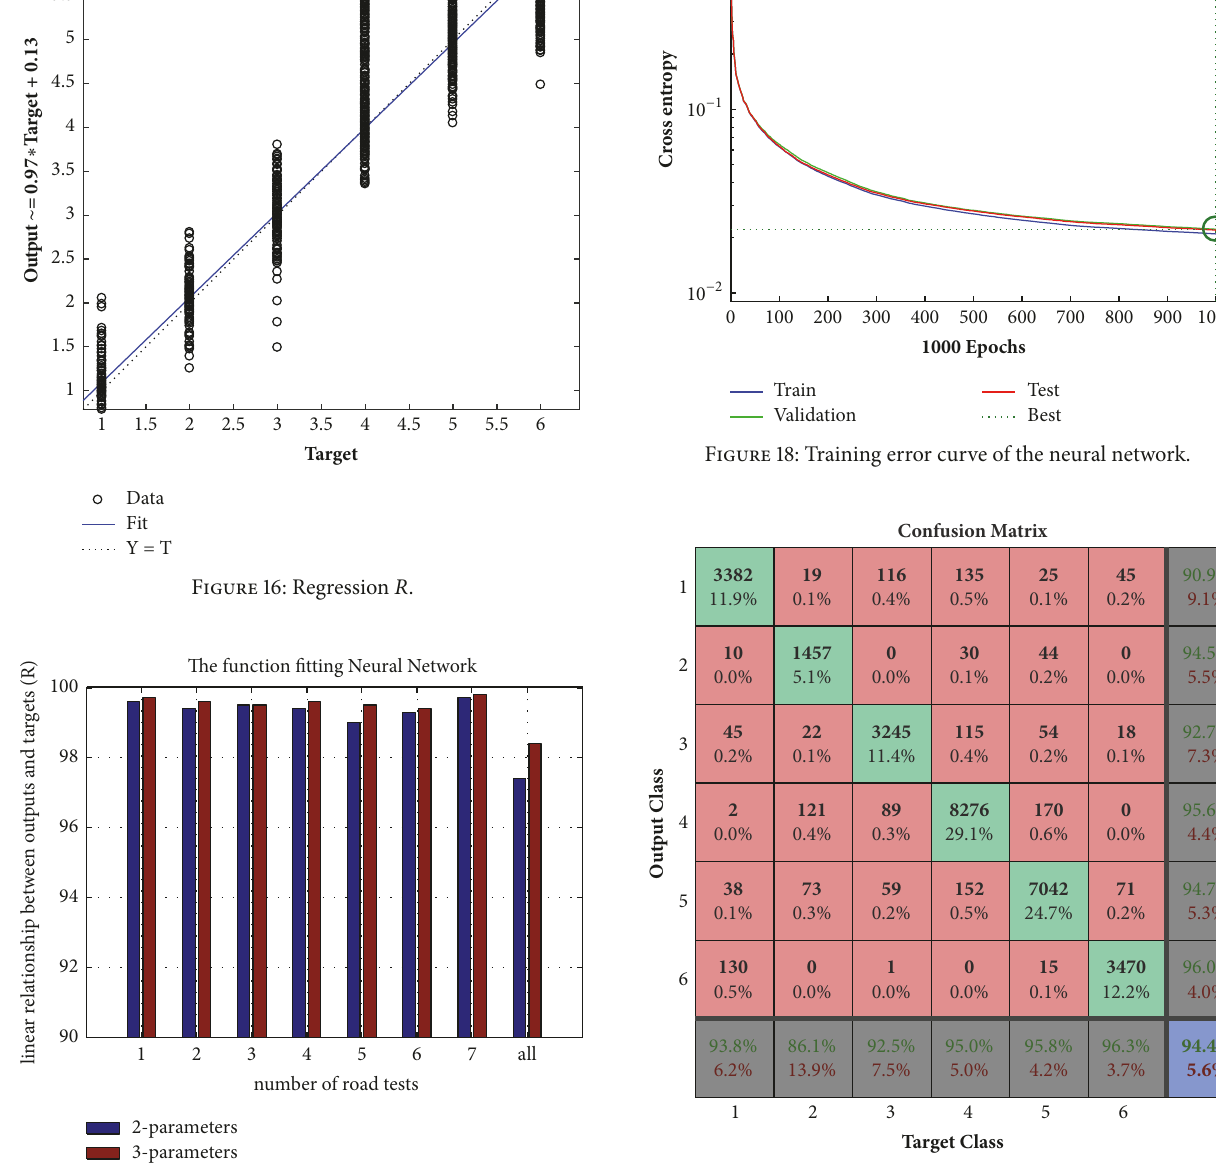
Figure 19: Accuracy of neural network